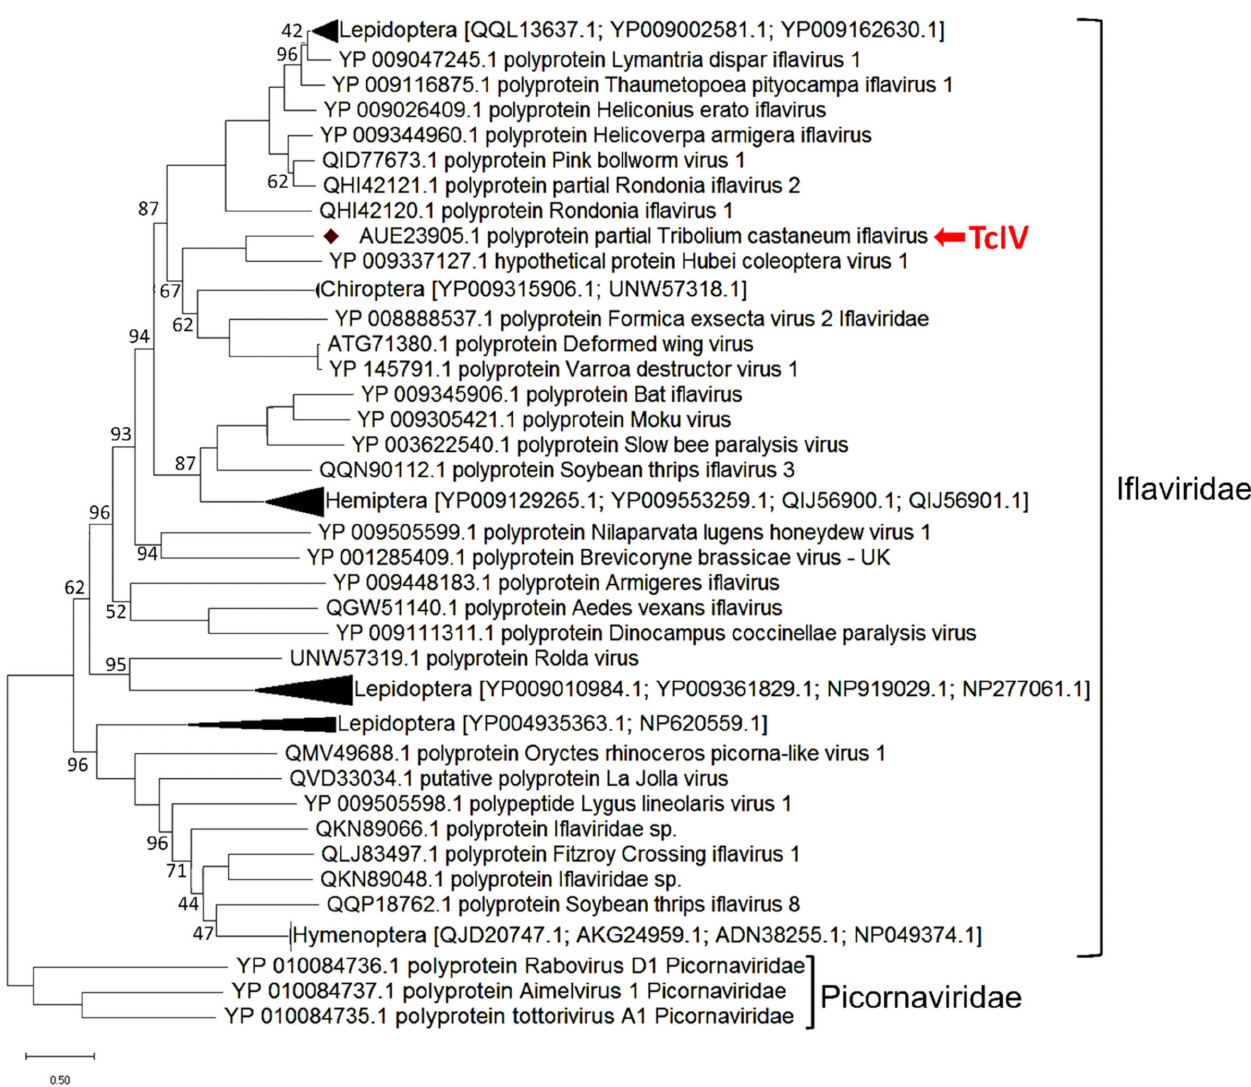
Figure 3. Evolutionary tree for TcIV with other members of iflaviridae. The tree was constructed using the Maximum Likelihood method with the JTT matrix model in MEGA based on a MUSCLE alignment. Three strains from family Picornaviridae were used as an outgroup. Bootstrapping values on each node represent the percent in 500 replicates. The nodes without value represent a bootstrap of 100. The black triangles represent the compressed branches with multiple taxa belonging to the same